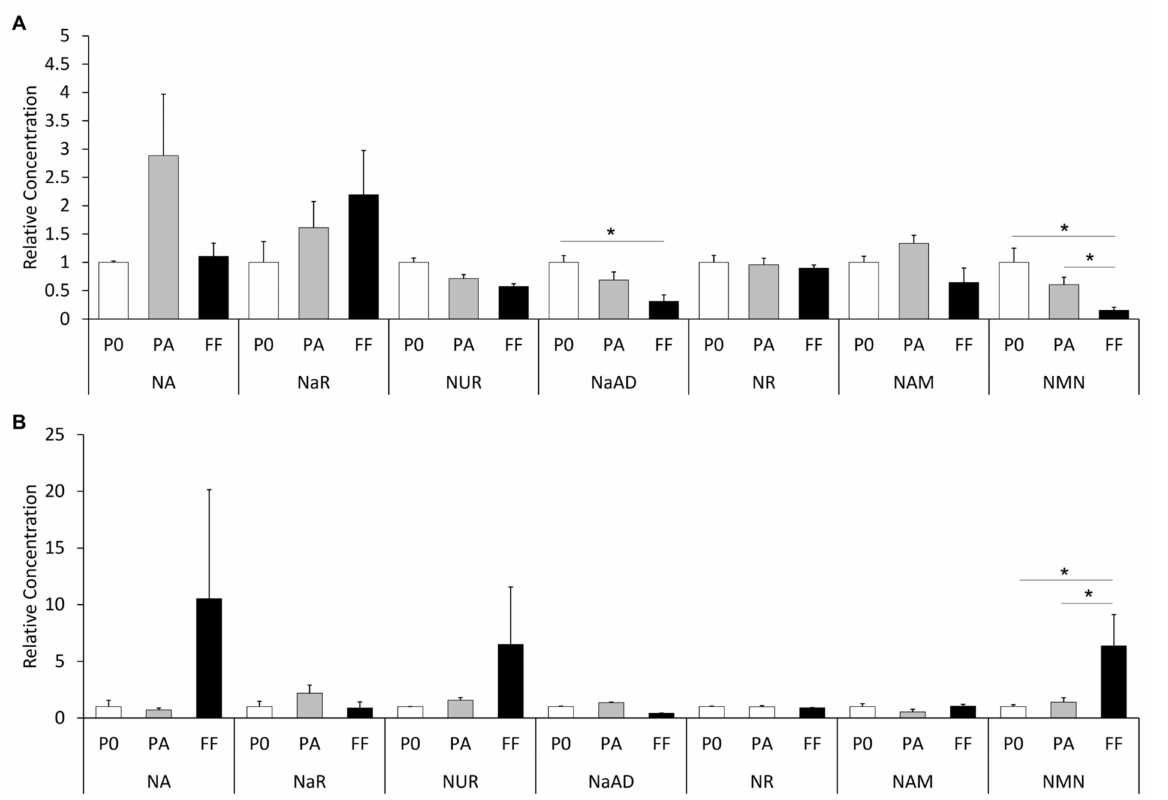
Figure 3. The relative concentrations of NAD + metabolites in the plasma and follicular fluid of ( A ) vehicle-fed and ( B ) NA-fed mares. Data are presented as a proportion of the baseline plasma prior to administration of the first feed (P0). PA–plasma at time of follicle aspiration, FF–follicular fluid. * indicates a statistical difference of p <